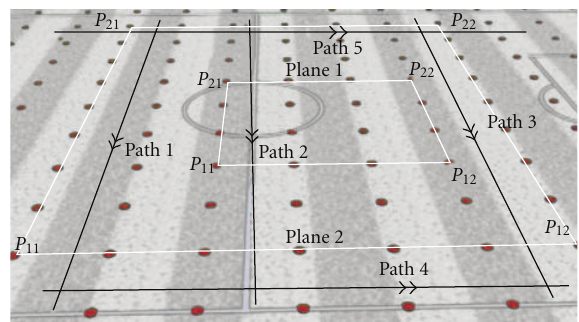
Figure 17: The tested five paths and two projection planes in the middle camera. Table 3: Experiment I results; comparing five paths using the image transformation algorithm and two projection planes. The comparison employs the RMSE over the two axes. RMSE